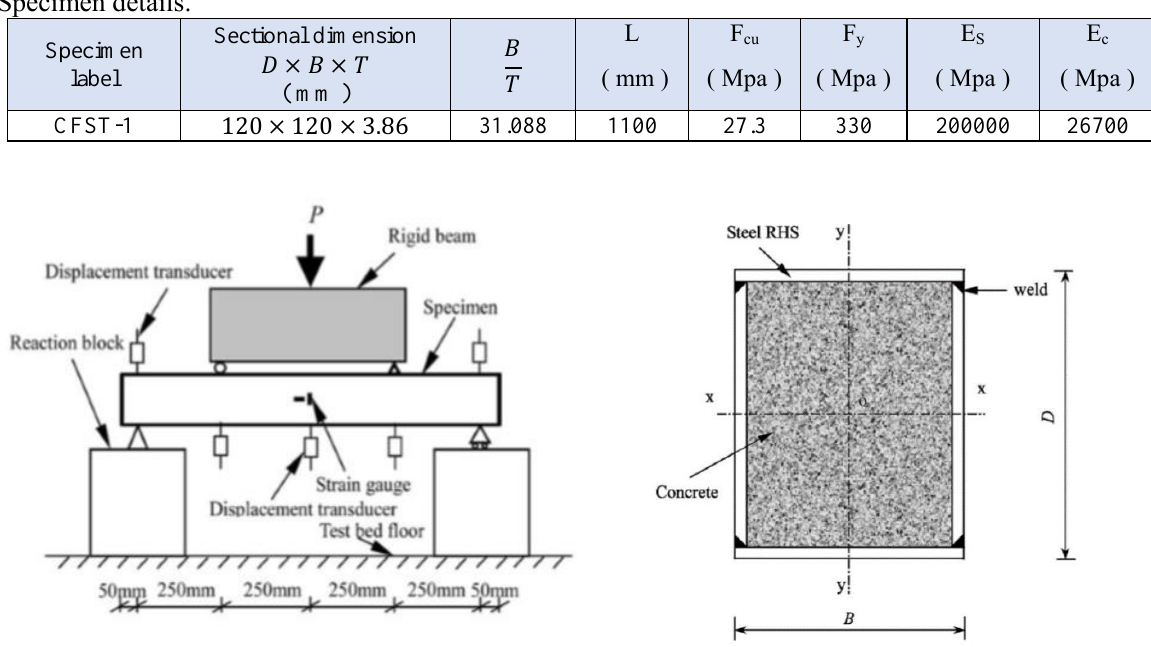
Specimen details.